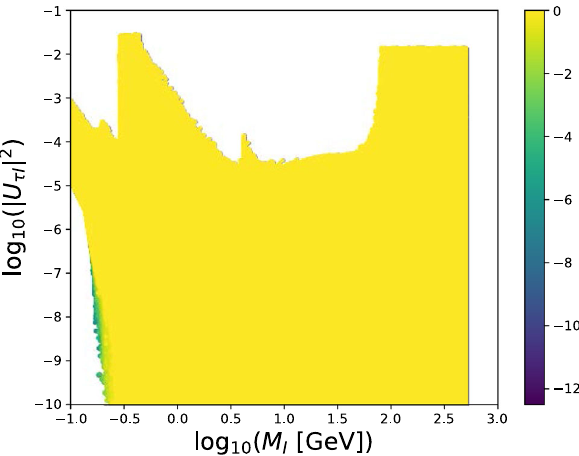
Fig. 38 Partial likelihood from the prompt searches with DELPHI, on the M